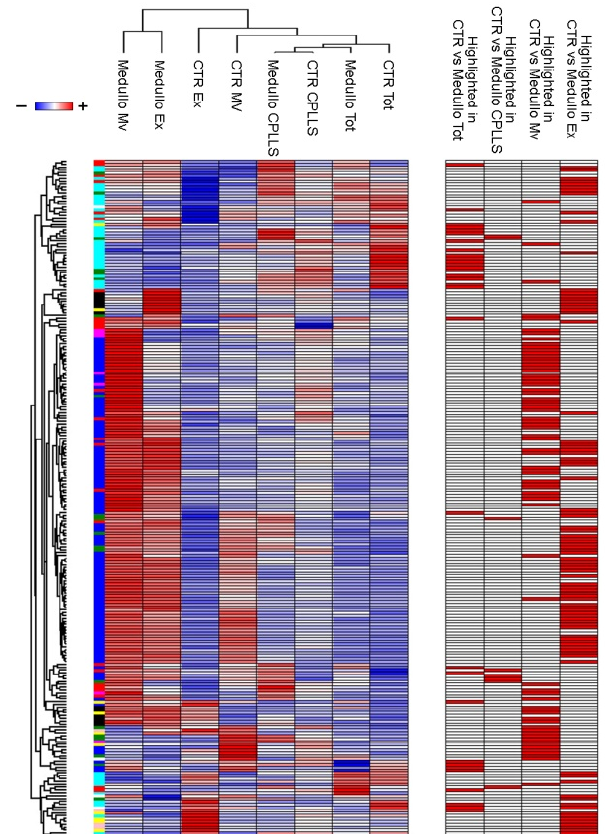
Figure 3. Heatmap of proteins that maximize the discrimination between MB and control samples. Heatmap of 192 proteins highlighted by the combined use of a t -test, Partial Least Square Discriminant Analysis (PLS-DA), and Support Vector Machine (SVM) learning analysis. In the heatmap, each row represents a protein, and each column corresponds to a sample (total, CPLL, Mv, and Ex of CSF from the EVD of MB and control patients). Normalized Z-scores of protein abundance are depicted by a pseudocolor scale (with red indicating positive expression; white, equal expression; and blue, negative expression, compared to each protein value). The dendrogram displays the outcome of unsupervised hierarchical clustering, placing similar proteome profile values next to each other. The co-expression modules identified are reported on the left of the heatmap. The statistically significant proteins identified in each comparison are highlighted in red on the right of the